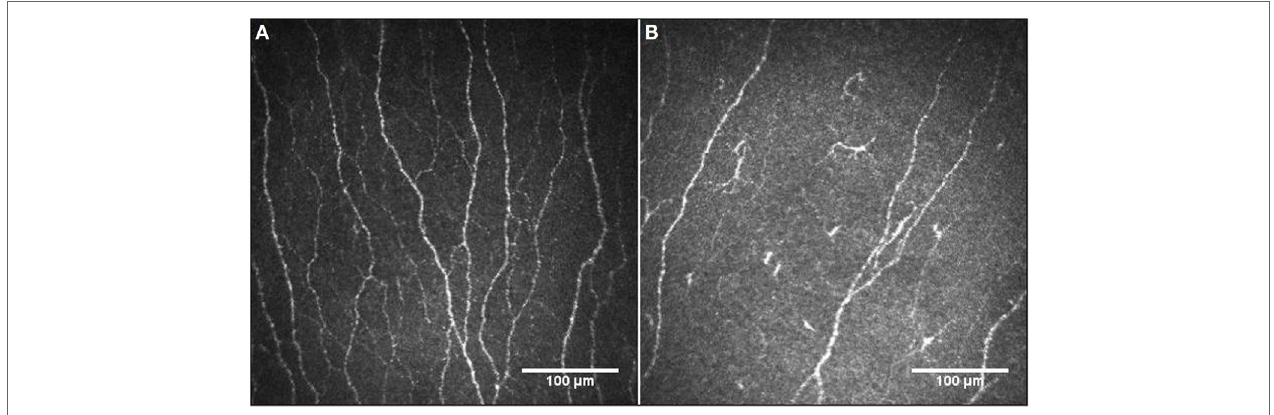
FigUre 2 | Representative corneal confocal microscopic images of the corneal nerve plexus in a healthy control participant (a) and a patient with Behçet’s disease (B) , showing reduced nerve fibers and increased dendritic